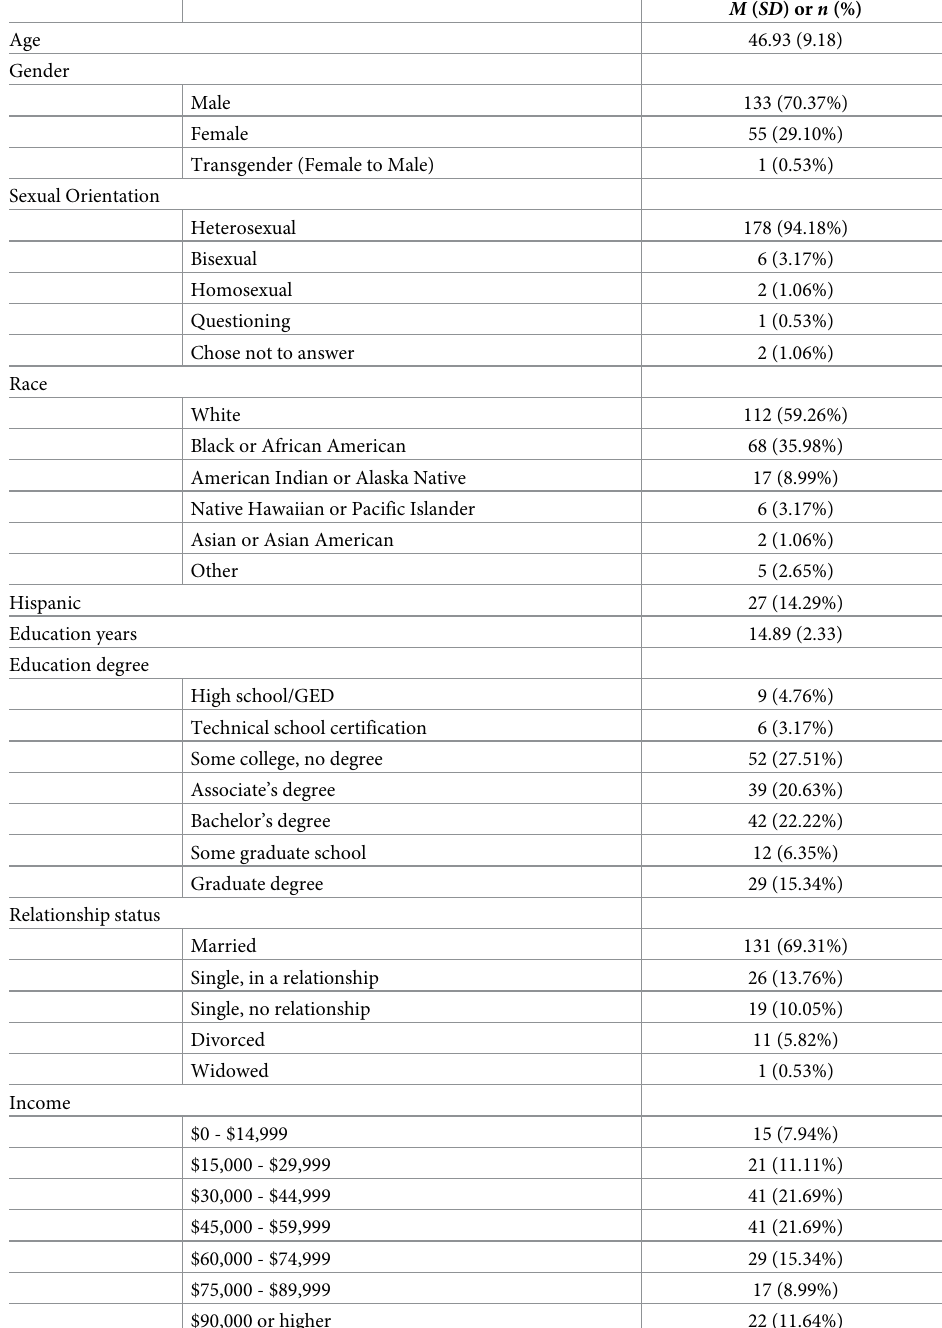
Table 1. Demographic